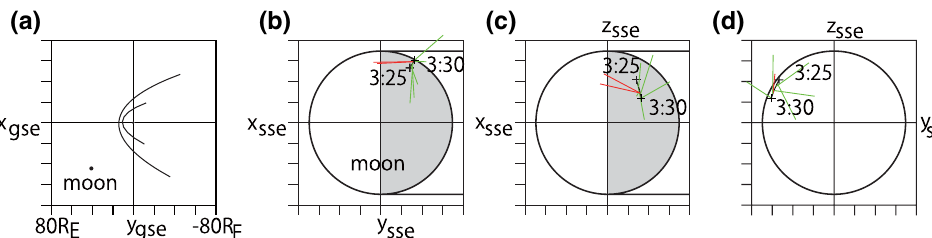
Fig. 7 Kaguya position and magnetic field vectors produced by a hot flow anomaly on 5 August 2008. The format is the same as in Fig. 2. Red bars represent directions of the 1-s averaged magnetic field vectors of the short-period magnetic enhancement at approximately its maximum intensity at 3:28:41, while green bars represent ambient magnetic field vectors plotted every 60 s during the period from 3:25 to 3:30